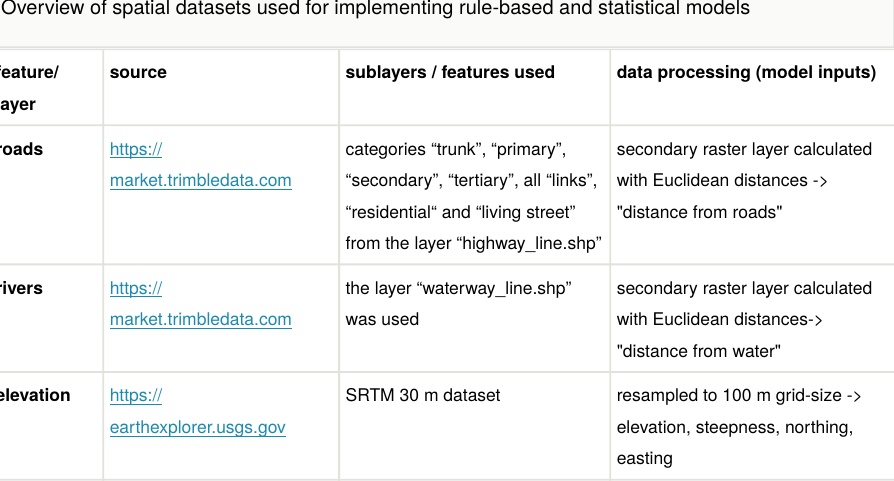
Overview of spatial datasets used for implementing rule-based and statistical